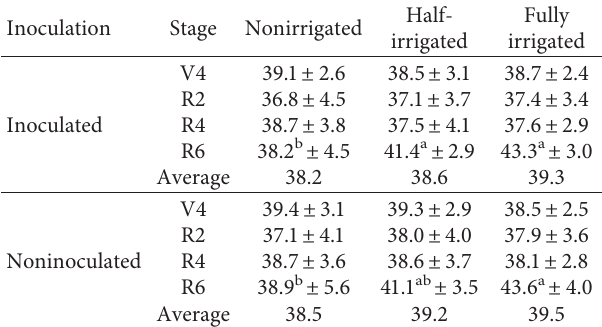
Table 3: The effect of different irrigation regimes on SPAD at different stages of soybean’s (cv. Bogl´ar) life cycle, averaged among 2017, 2018, and 2019 in Debrecen, Hungary.